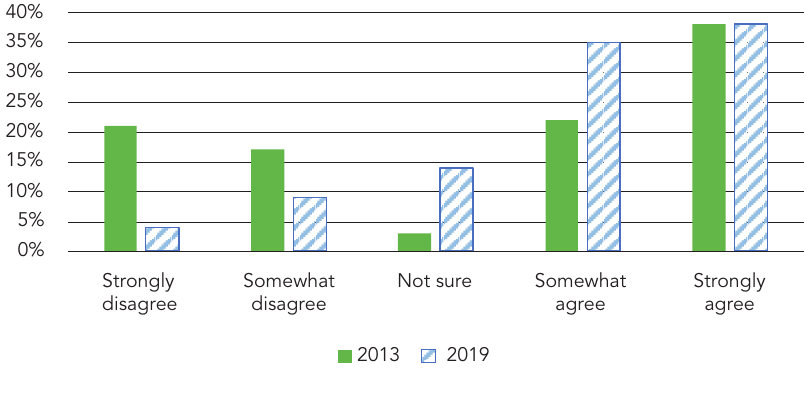
Chart 5: Attitudes: Rate whether you agree or disagree with the statement ‘Stabilising population growth will help protect the